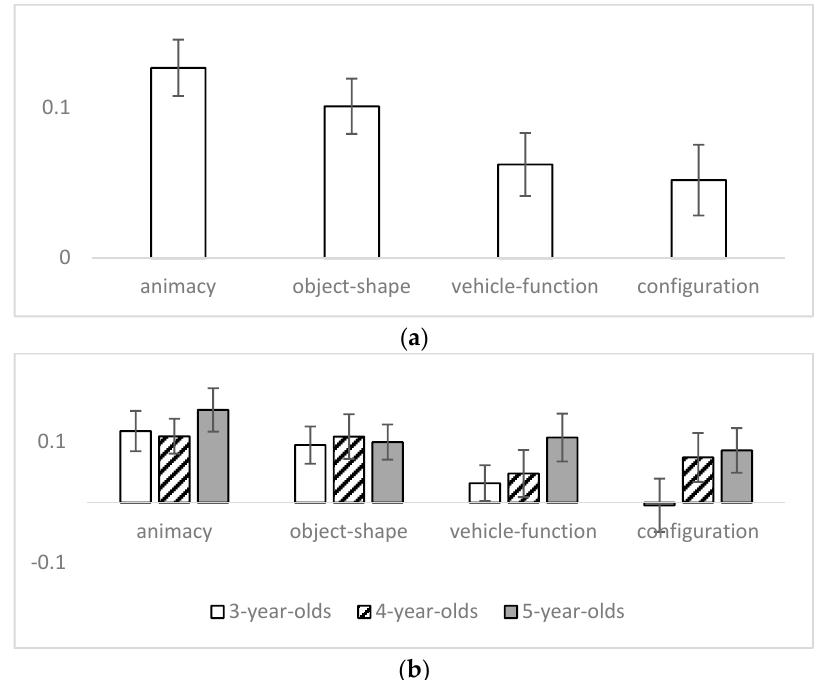
Figure 1. ( a ) The TF increase for each type of classifiers across all participants. ( b ) The TF increase for each type of classifiers within each age group. Error bars reflect SEM.